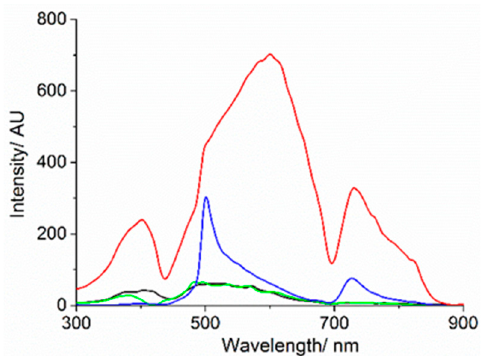
Figure 3. Resonance light scattering (RLS) spectra of Au 10 in aqueous solution (black line), TPPS@Au 10 in aqueous solution (green line), upon addition of HCl (pH 2) after 1 h (blue line) and after 24 h (red line). ([Au 10 ] = 125 μ M, [TPPS] = 5 μ M).